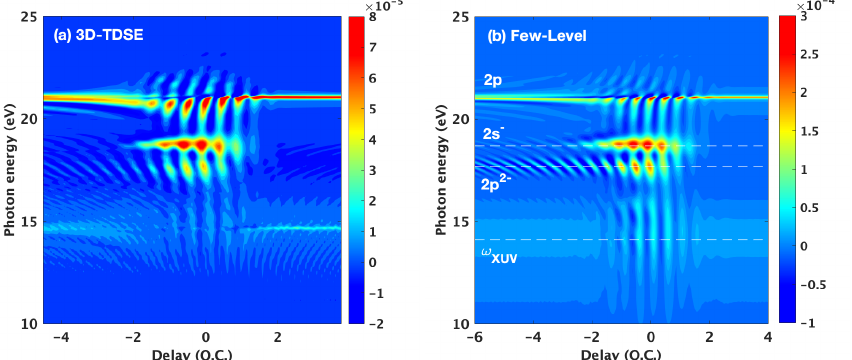
Figure 1. The ATA spectra (color coded) of the helium atom calculated from the response function S ( ω , t d ) using the 3D-TDSE ( a ) and three-level model ( b